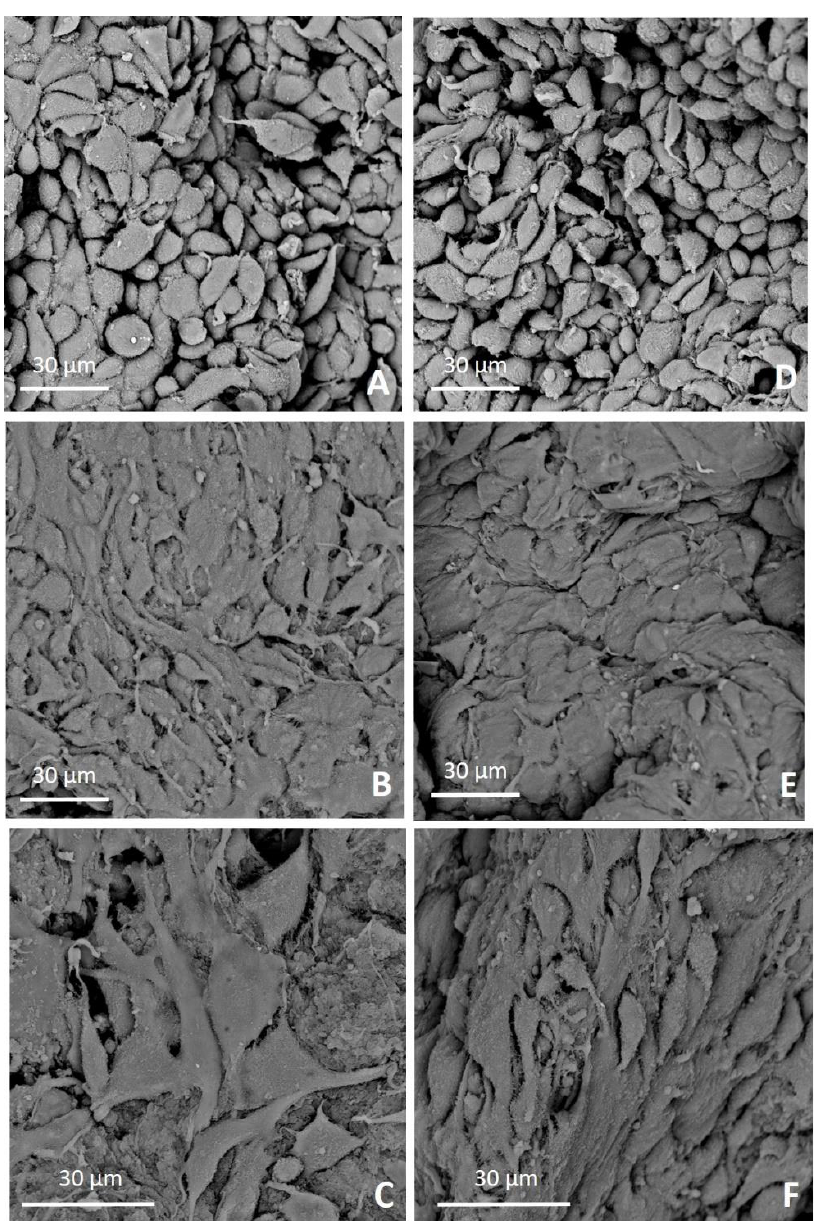
Figure 8. SEM microphotographs of MG-63 adhesion on 4-StarPEG crosslinked Coll/MBG_Sr4% at 24 h ( A ) and 72 h ( B , C ), and non-crosslinked Coll/MBG_Sr4% after 24 h ( D ) and 72 h ( E , F ).